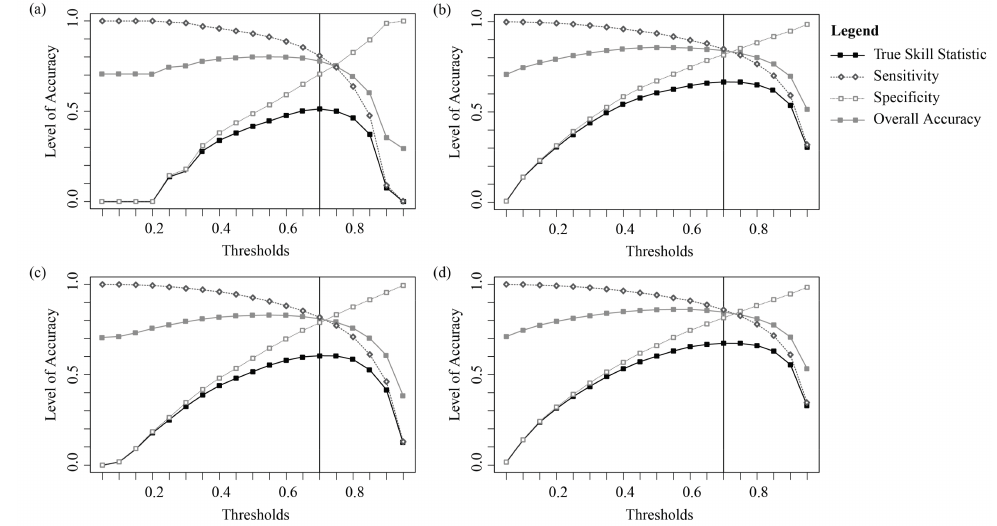
Figure 5. True Skill Statistic (TSS), sensitivity, and specificity values calculated and plotted over a series of probability classification thresholds for the four models: ( a ) T model , ( b ) TO model , ( c ) TS model , and ( d ) TOS model